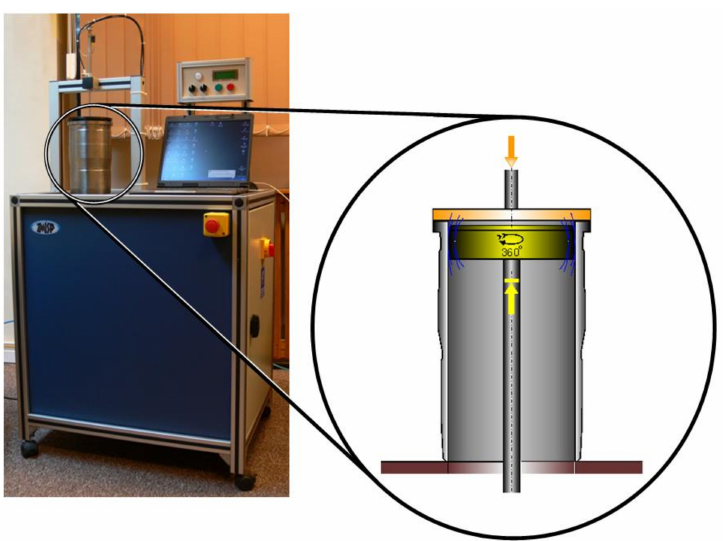
Figure 1. The Geoform measurement system with the measured